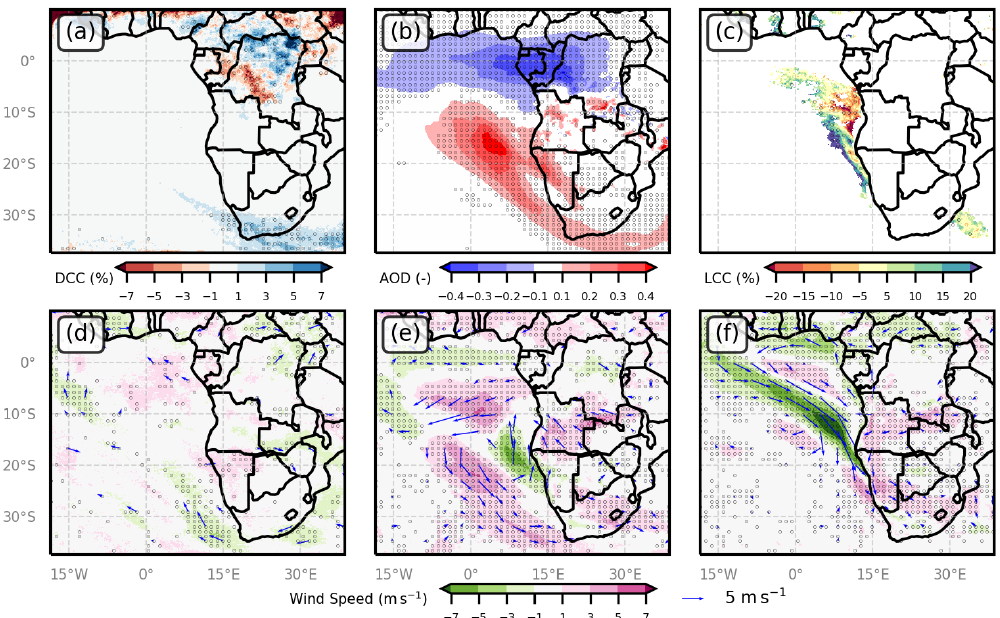
Figure 4. Changes between BBRAD and NORAD ensemble means in the (a) occurrence of deep convective clouds, (b) AOD, (c) occurrence of low-level clouds and wind speed at (d) 12km, (e) 4km and (f) 1km a.g.l. Black dots indicate where changes in deep convective clouds, AOD, low-level clouds and wind speed are statistically significant at the 0.05 level. Arrows indicate wind field anomalies when significant at the 0.05 level. Fields are averaged between 8 and 16 September